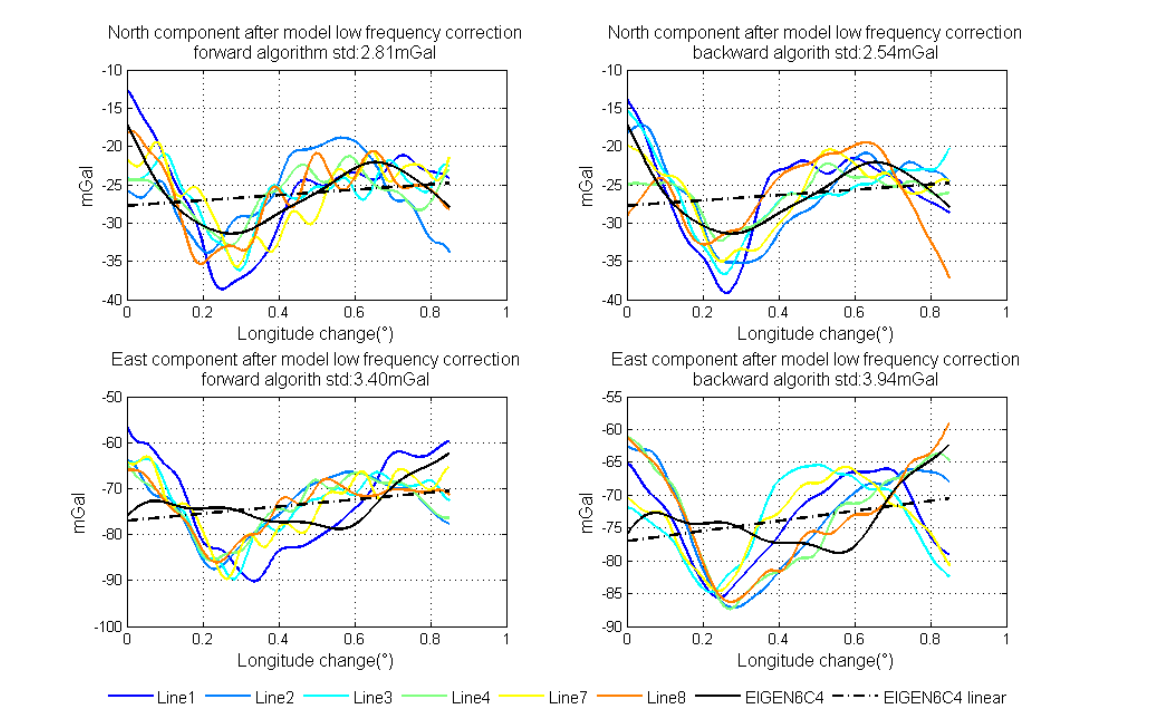
Figure 17. North and east components of gravity disturbance after correction by